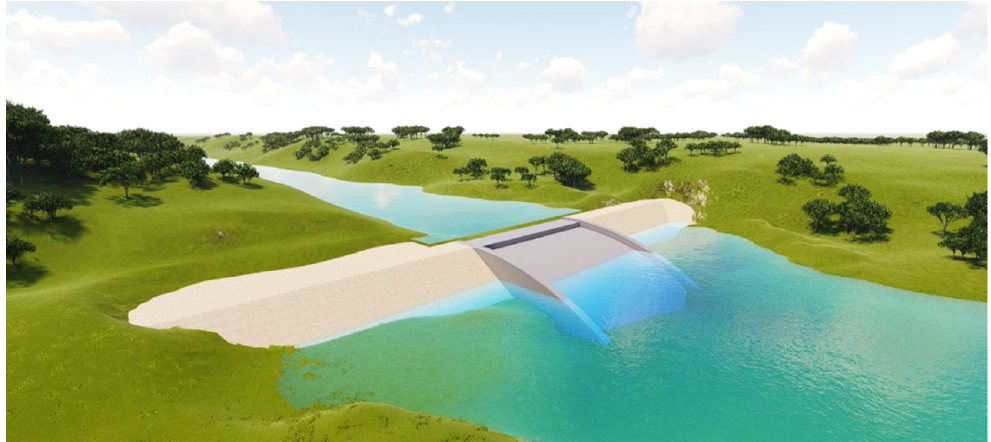
Figure 12. Three-dimensional view of the designed dam.